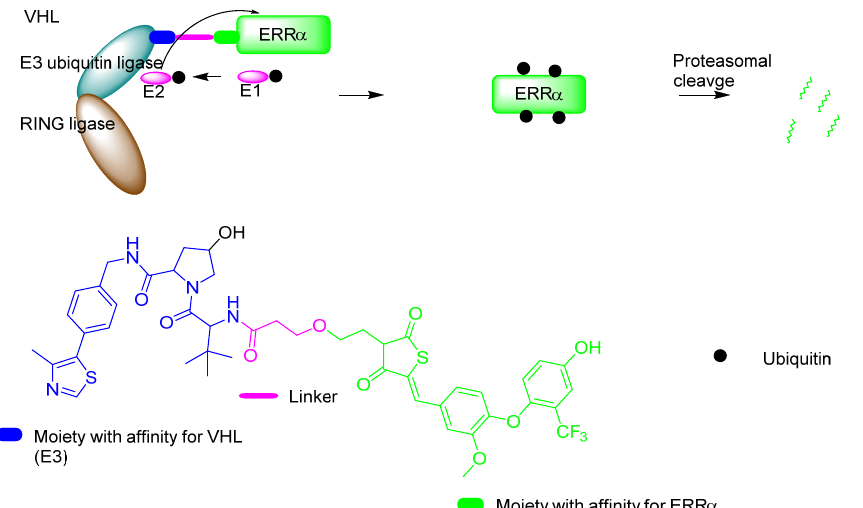
Figure 7. Cartoon illustrating the principle of protease-targeting chimera (PROTAC) [9,10,80]. A compound with affinity for the Hippel–Lincau-cullin-Ring (VHL) complex and the target protein (e.g., estrogen-related receptor α (ERR α )) is used to attach the protein to the E3 ligase in the VHL complex. After complexation the E3 conjugates ubiquitin to the protein making it a target for proteasomal degradation.